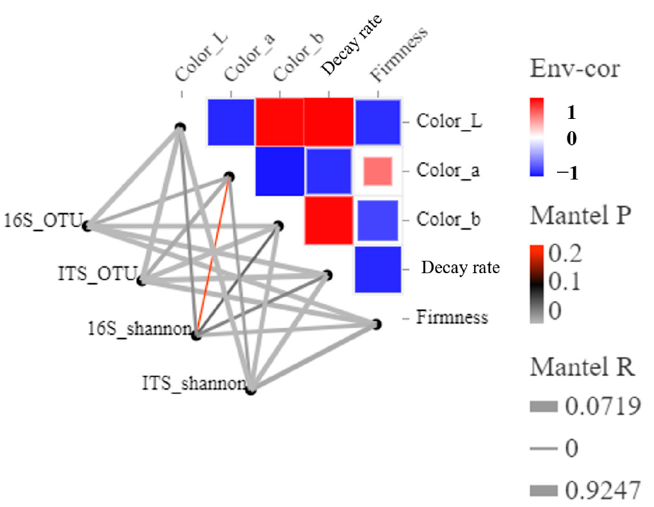
Figure 6. Correlations between fungal taxa (ITS) and bacterial taxa (16S) and the apparent characteristics of blueberries after storage. Red squares represent significant ( p < 0.05 after FDR adjustment) negative correlations. Blue squares represent significant ( p < 0.05 after FDR adjustment) positive correlations. Darker colors represent stronger correlations. Non-significant correlations are not shown.